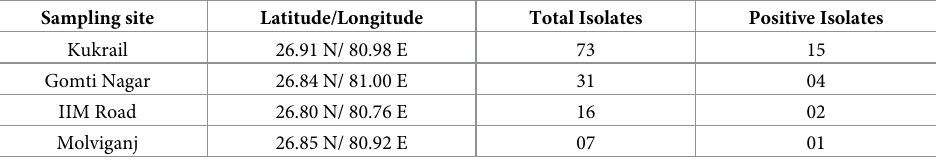
Table 1. Soil samples taken from different locations of Lucknow, UP,